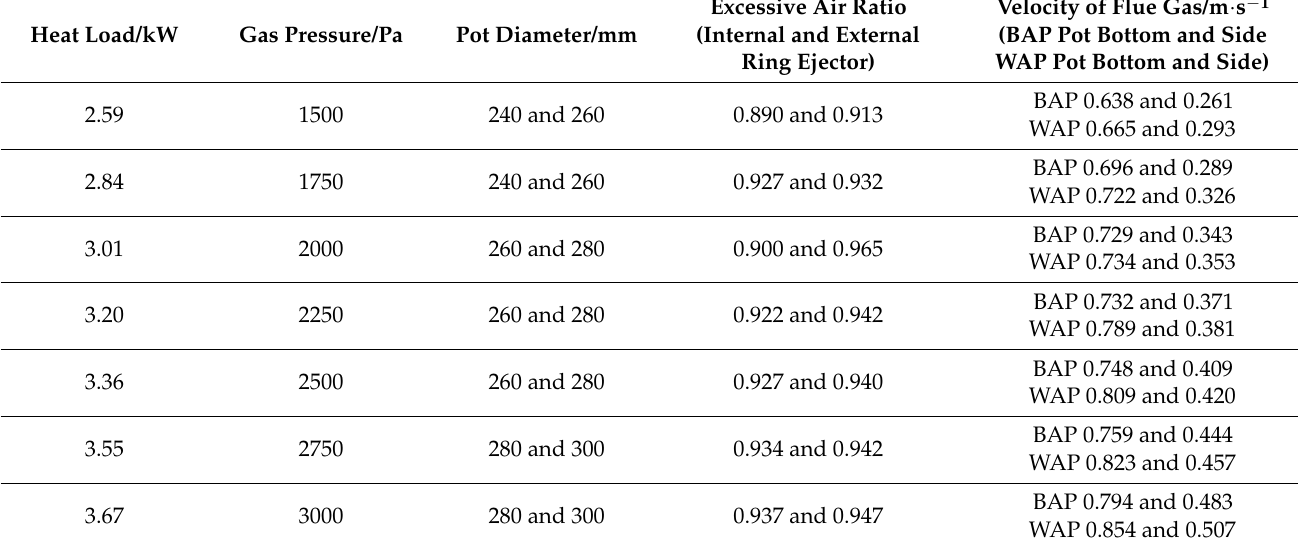
Table 1. Operating